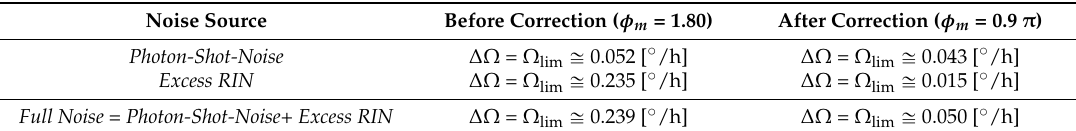
Table 4. Photon-Shot-Noise and excess RIN noise before ( φ m = 1.80) and after ( φ m = 0.9 π )